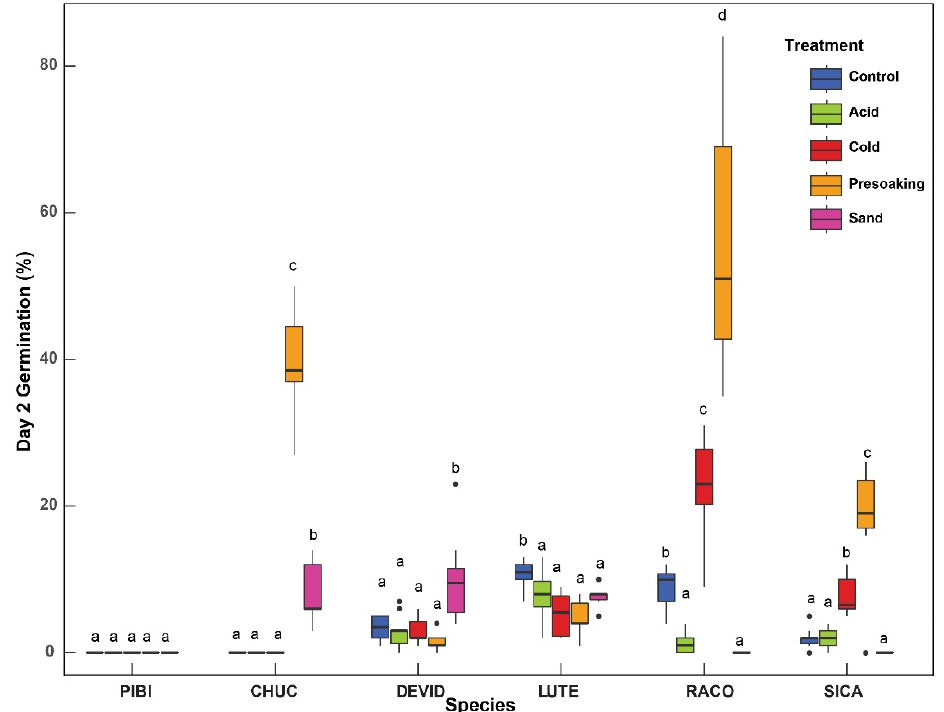
Figure 3. A representation of differences in germination on day 2, between treatments within each selected Species. Significant differences on day 2 germination within each species were evaluated using multiple comparisons-adjusted Tukey’s HSD test. P. bicolor (PIBI) , C. cucullata (CHUC), D. vir- gatus (DEVID, L. texensis (LUTE), R. columnifera (RACO), S. calva (SICA). Significant determinants ( p < 0.05) are denoted within species with letter characters.